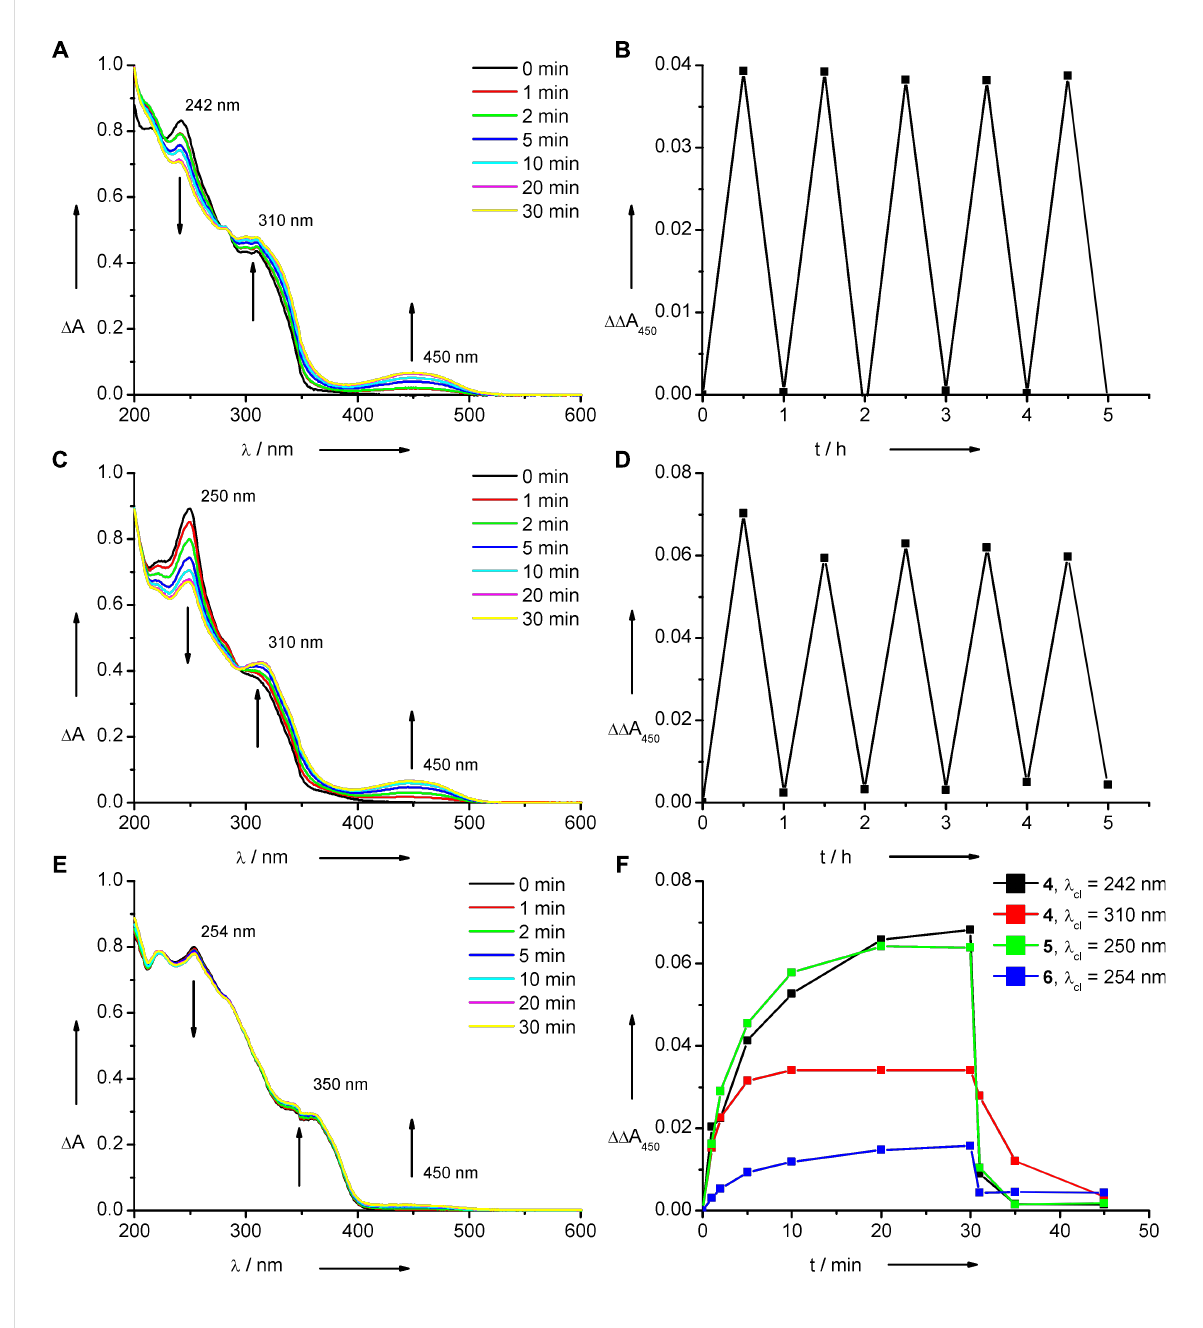
Figure 1: Photoswitching properties of nucleosides 4 – 6 (each 20 mM in MeCN, rt). Top: Irradiation of 4 at 242 nm ( A , left) and irradiation of 4 alter- nating at 242 nm and 450 nm ( B , right). Middle: Irradiation of 5 at 250 nm ( C , left) and irradiation of 5 alternating at 250 nm and 450 nm ( D , right). Bottom: Irradiation of 6 at 254 nm ( E , left) and plots of kinetic traces of absorption changes at 450 nm of all nucleosides 4 – 6 irradiated at the corres- ponding wavelength until 30 min, then at 450 nm ( F , right).